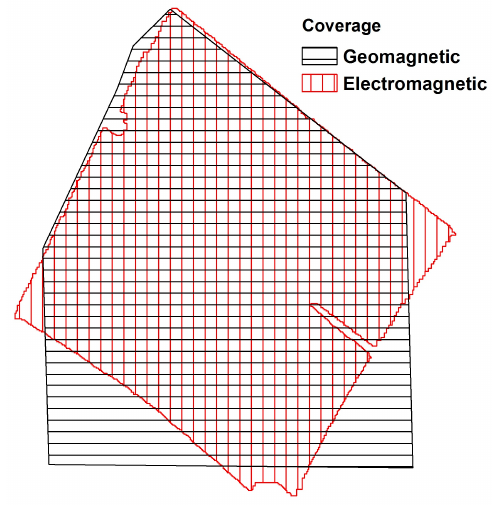
Figure 4. Magnetic susceptibility ( a ); and electromagnetic conductivity ( b ) results from Almyros 2.